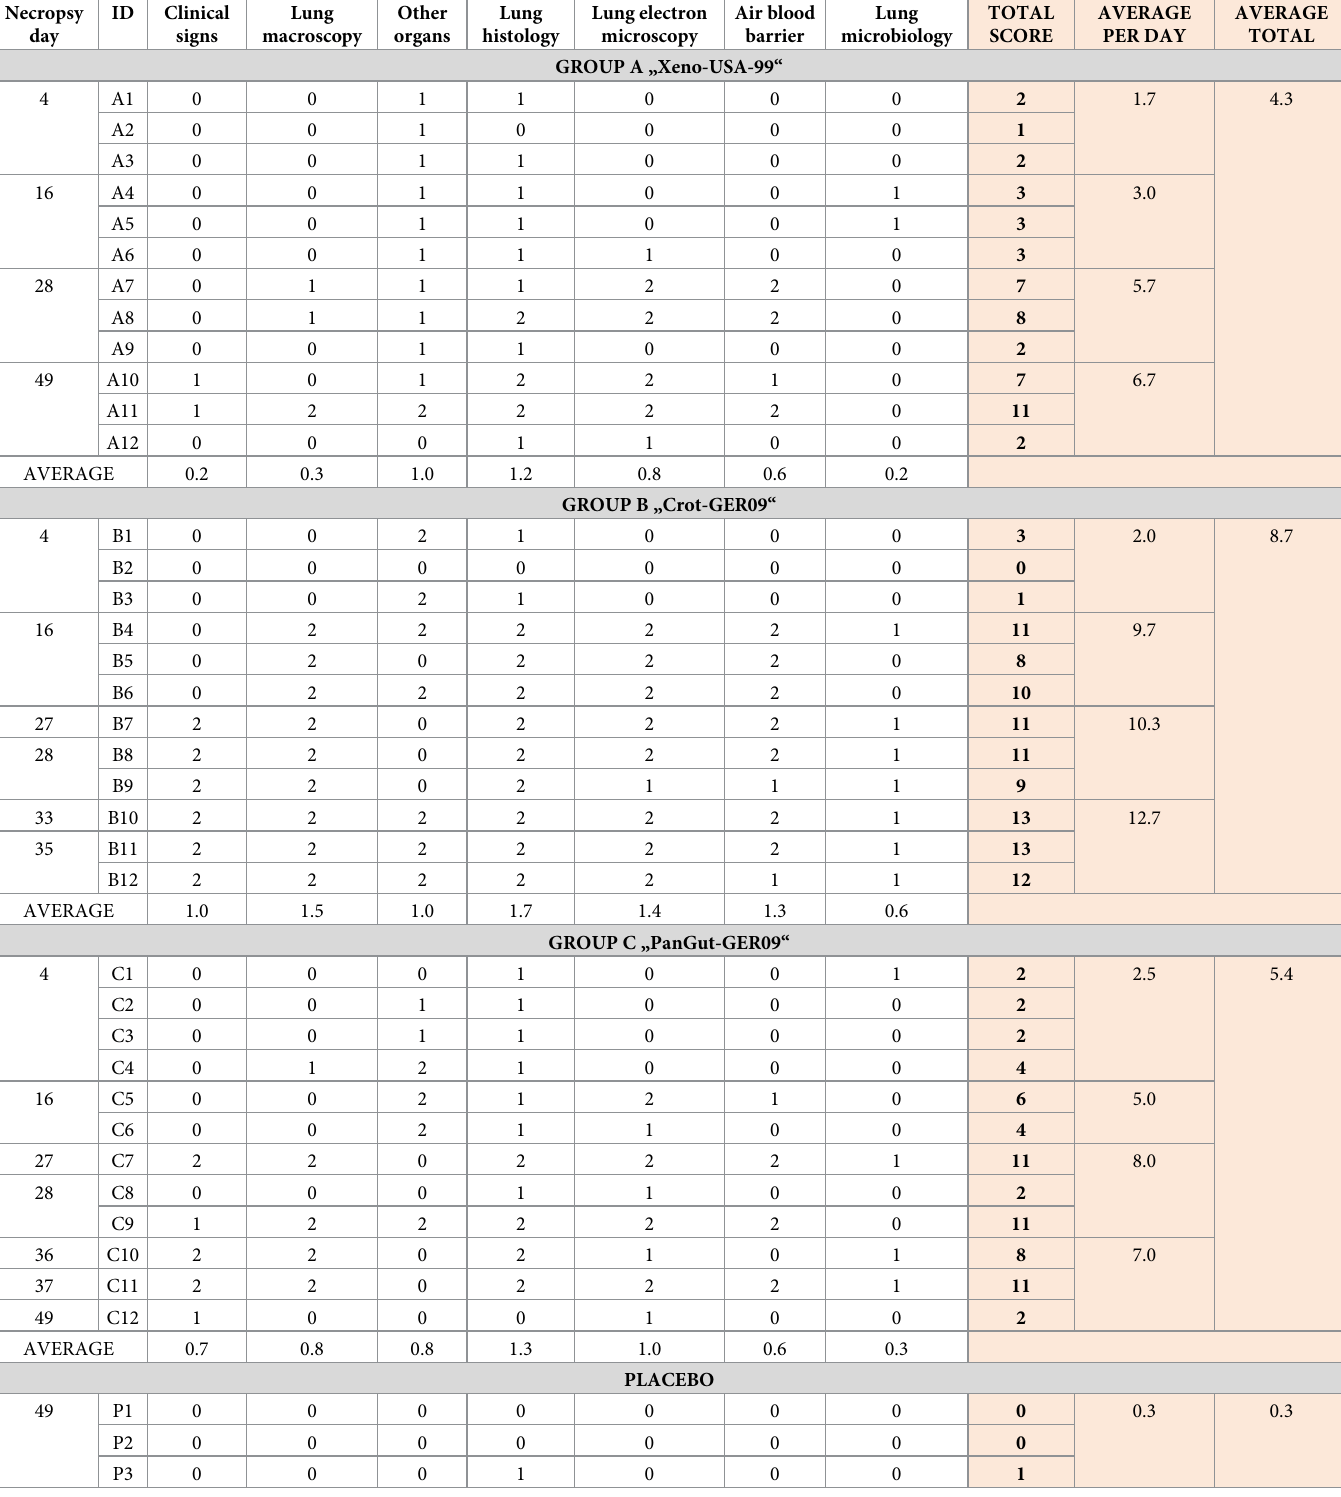
Table 2. Evaluation scores given for each animal and each criterion. Except for the criterion “lung microbiology” (0 –unremarkable, 1 –remarkable), the scores were given as follows: 0 –unremarkable, 1 –moderate change, 2 –severe